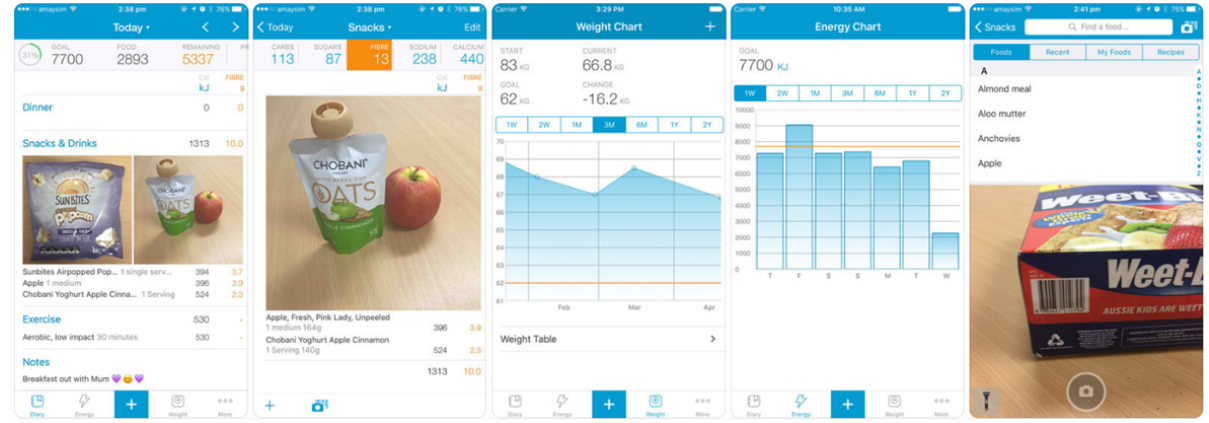
Figure 1. Screenshots of the Easy Diet Diary app (Xyris Software Australia Pty